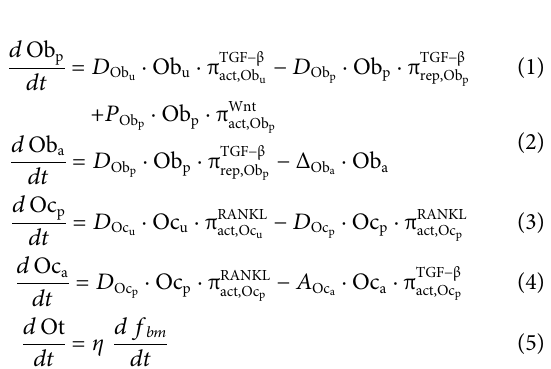
FIGURE 1 | Schematic representation of the proposed PK model. The framed box represents the 1-compartment PK model proposed by Marathe et al.(Marathe et al.,2011).Thebone compartmenthasbeen added hereand the fl ux of Dmab from the central compartment to the bone compartment represents the production term in the competitive binding reactions between RANKL, OPG and